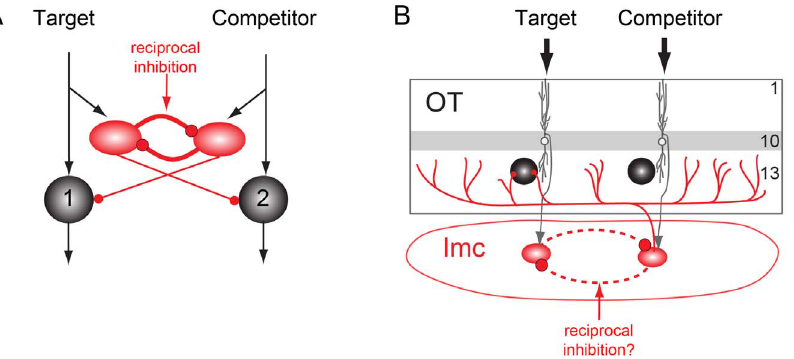
Figure 1. Reciprocal inhibition of inhibition in the midbrain selection network. A) Computational model: Schematic of a lateral inhibitory circuit with long-range projections from the inhibitory units (red ovals) to the excitatory output units (black circles). Black arrows indicate excitatory connections, red circles represent inhibitory connections. One channel (1) represents a target stimulus; the other (2) represents a competitor stimulus. Reciprocal feedback inhibition between inhibitory units is depicted with solid lines. Adapted from [2]. B) Anatomy: Schematic of midbrain selection network. Neurons in layer 10 of the OT (white circles, grey dendrites) send topographic projections to Imc neurons (red ovals). Imc neurons send widespread GABAergic projections to neurons in the intermediate/deep layers of the OT (black circles). Putative reciprocal inhibition between spatial channels is depicted with dashed lines.